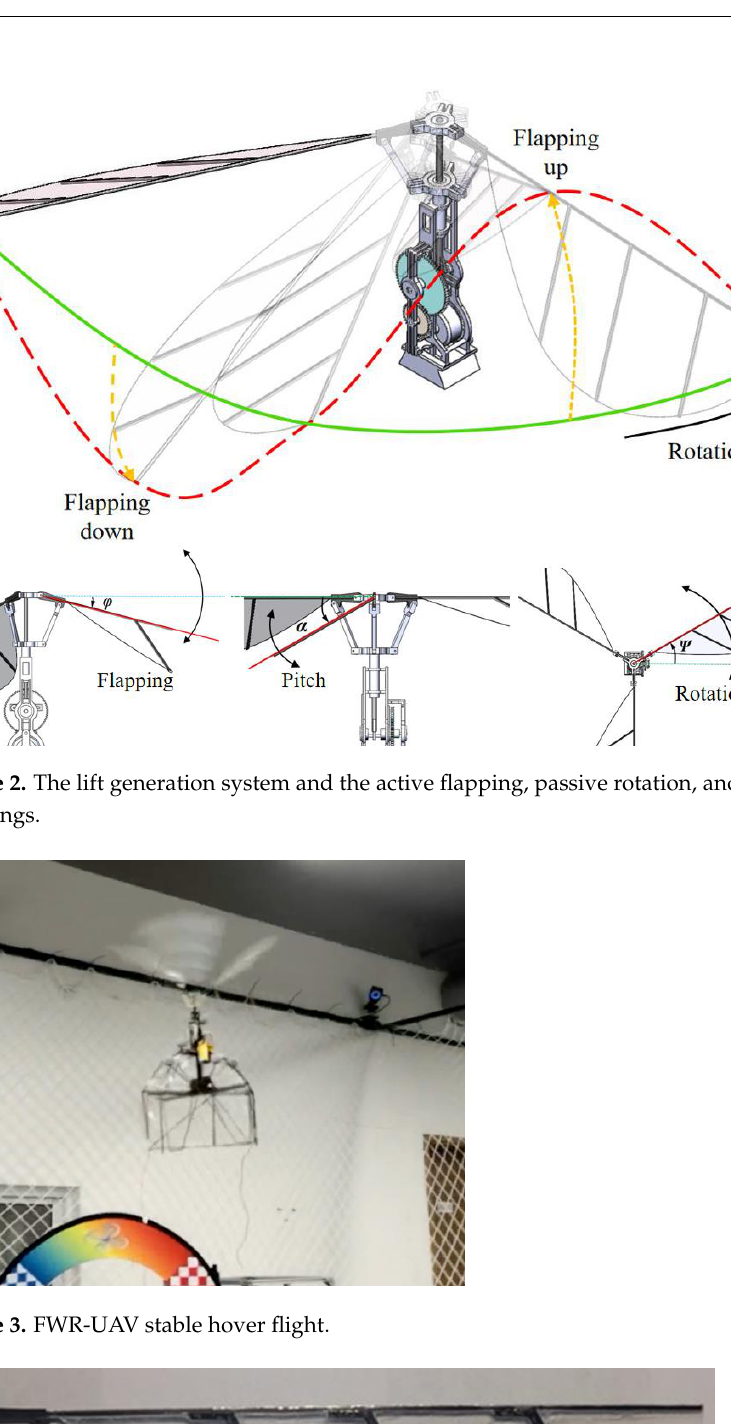
Figure 3. FWR-UAV stable hover flight.